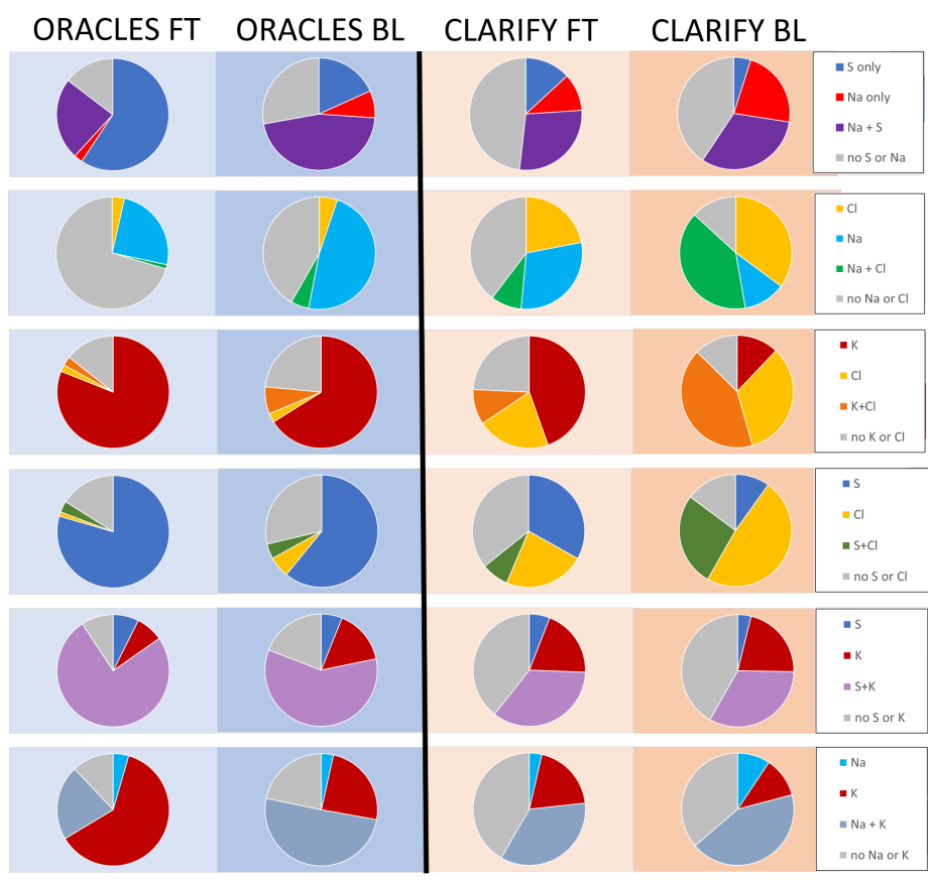
Figure 10. Elemental mixing states for select elemental pairs for ORACLES (two left columns) and CLARIFY (two right columns), sepa- rated by filter collection in the free troposphere and boundary